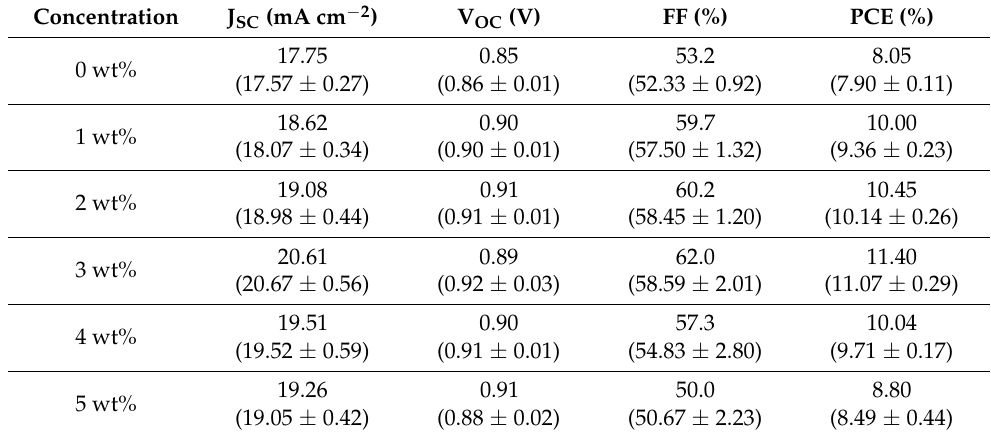
Table 1. Solar cell parameters of PSCs with Brij C10-mixed PEDOT:PSS HTL.